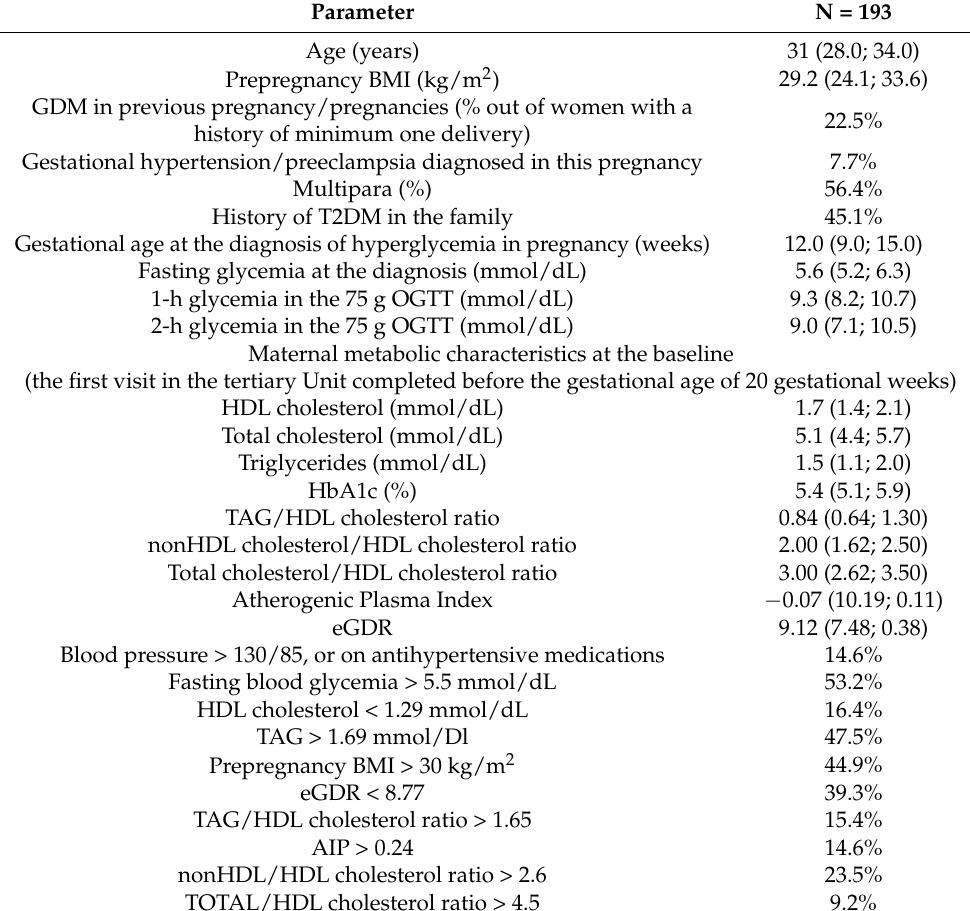
Table 1. Maternal characteristics of the study group; data presented as median (interquartile range), or